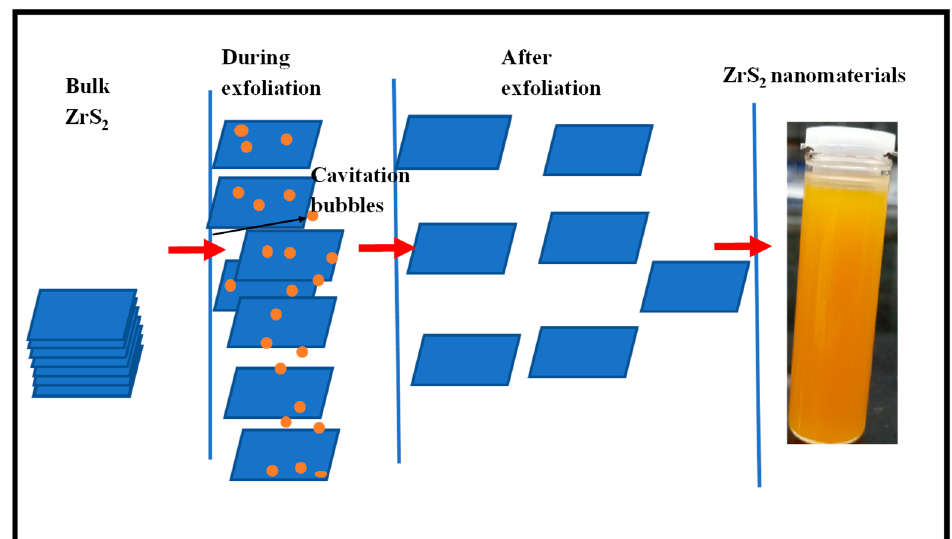
Figure 5. Schematic illustration of exfoliation of ZrS 2.